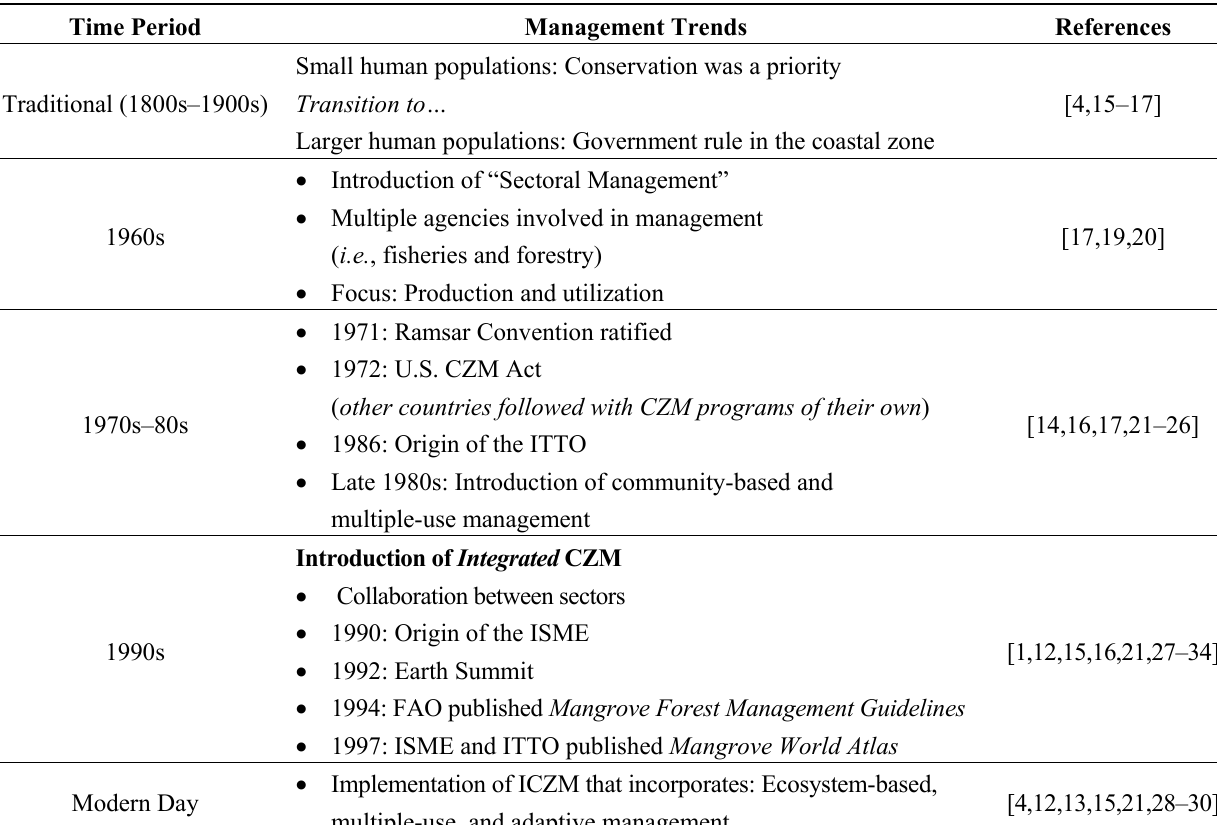
Table 1. Timeline of coastal zone management history and the associated